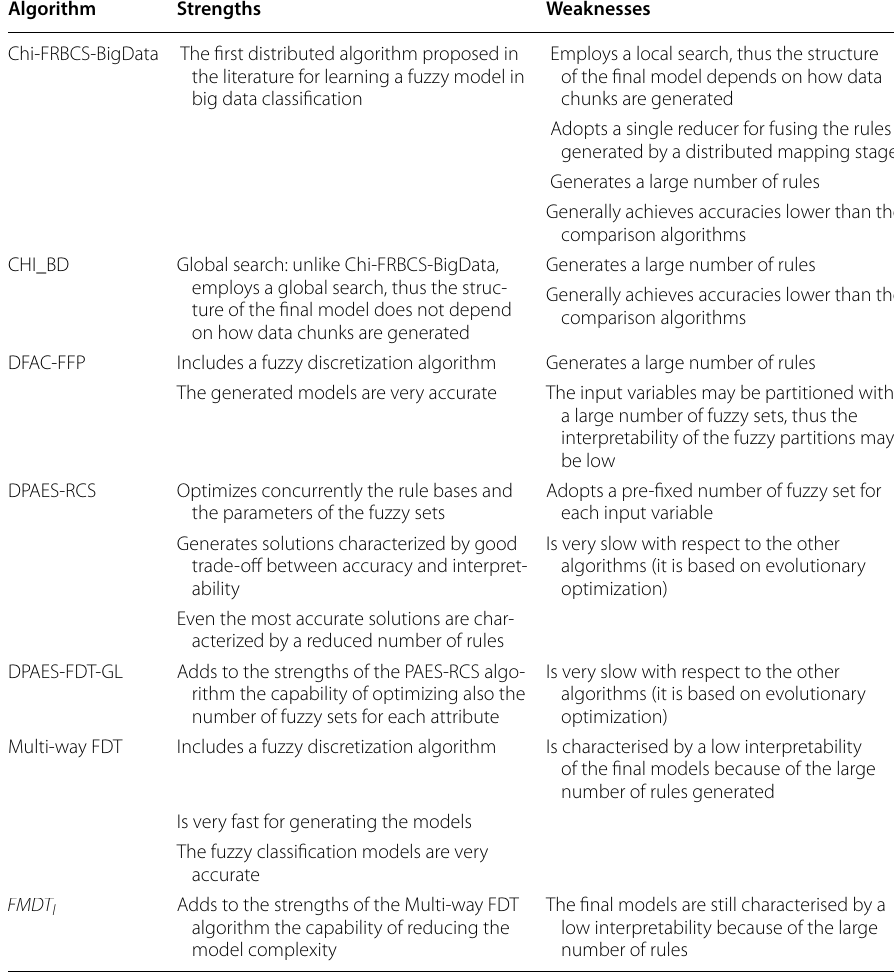
Table 5 Algorithms used in the experimental comparison, strengths and weaknesses Algorithm